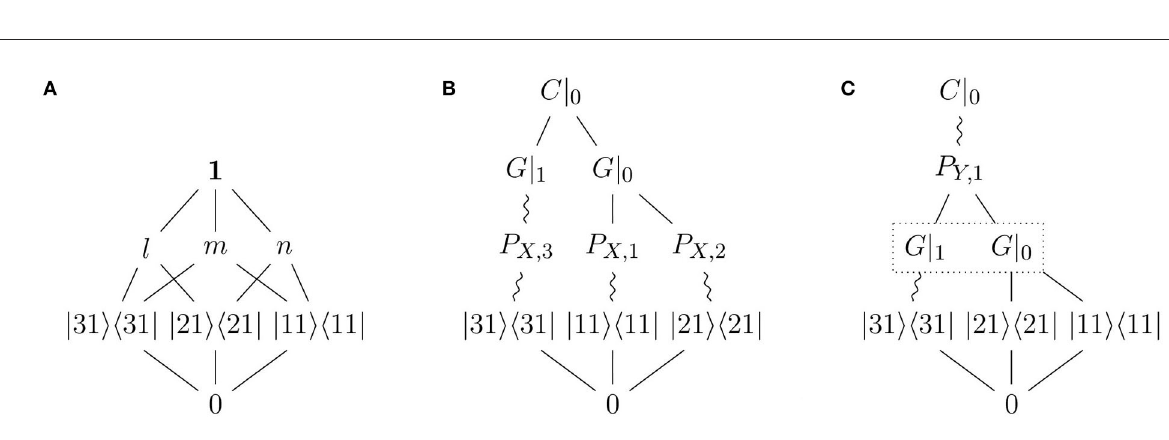
FIGURE9 The logical view on M ( B ) (A) and the structures for H X (B) and H Y (C) after m 3